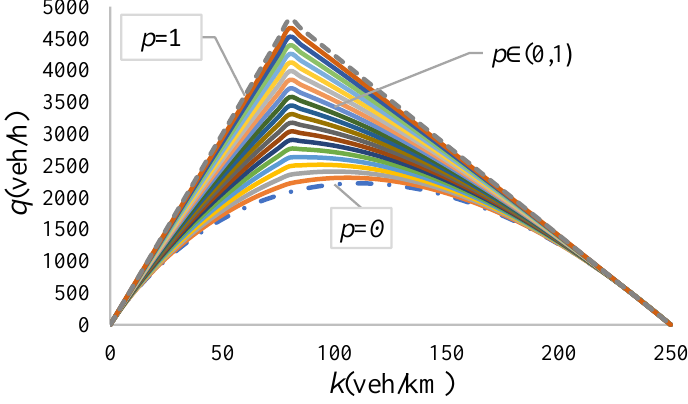
Figure 12 . q-k change with different p . Table 5. Matching data with different p (partial data).